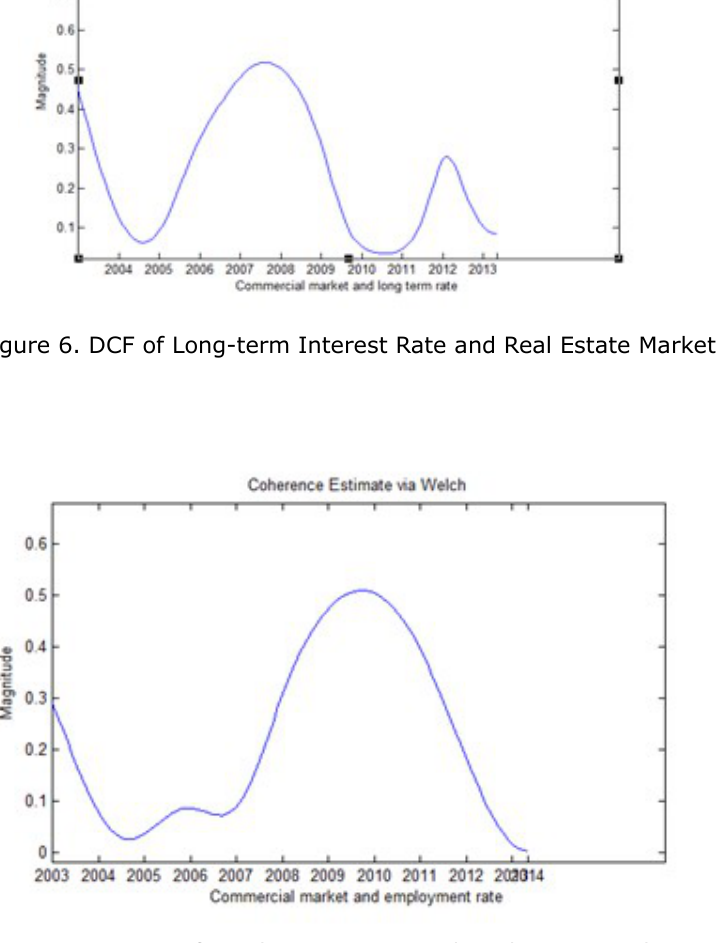
Figure 7. DCF of Employment Rate and Real Estate Market